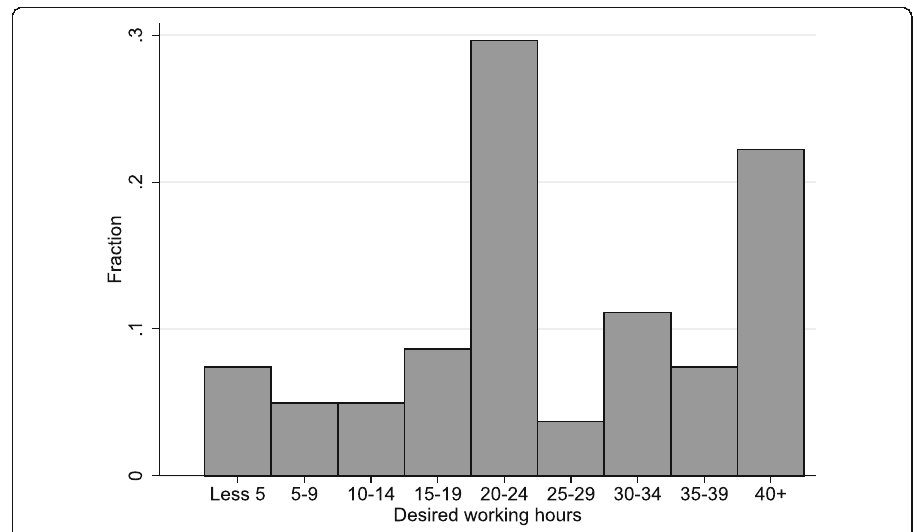
Fig. 2 Distribution of desired intensity for retirees who would like to work. Notes: 81 observations